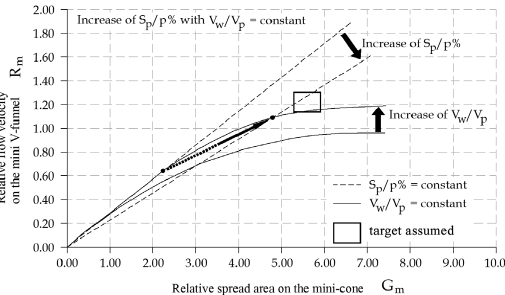
Figure 3. Changes in the workability parameters with the increase of S /p%, keeping V p